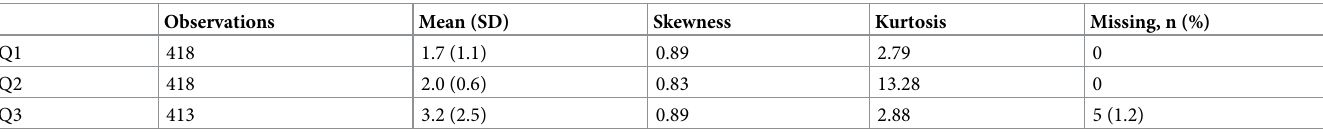
Table 2. Skewness and Kurtosis for Q1-Q3.